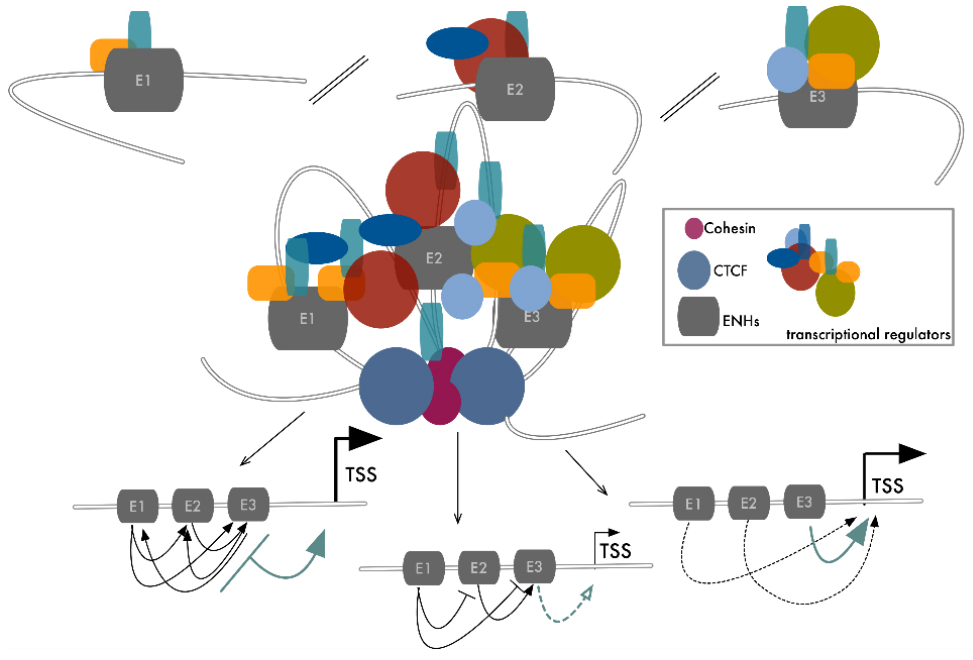
Figure 2. Long range-interaction among distal ENHs results in a 3D assembly similar to SE-like structures. Here we present a hypothetical model of distantly interspersed ENHs’ cooperative interaction. The loading of transcription factors to each functionally related ENH, coupled with the 3D folding of chromatin, facilitates the formation of a large and high-density complex of transcription regulators in close proximity to the target TSS. CTCF dimers and cohesin contribute to system isolation. Within this functional domain, each ENH conditions the activity of the other elements in different ways, which depend primarily on the context-specific meaning of their target